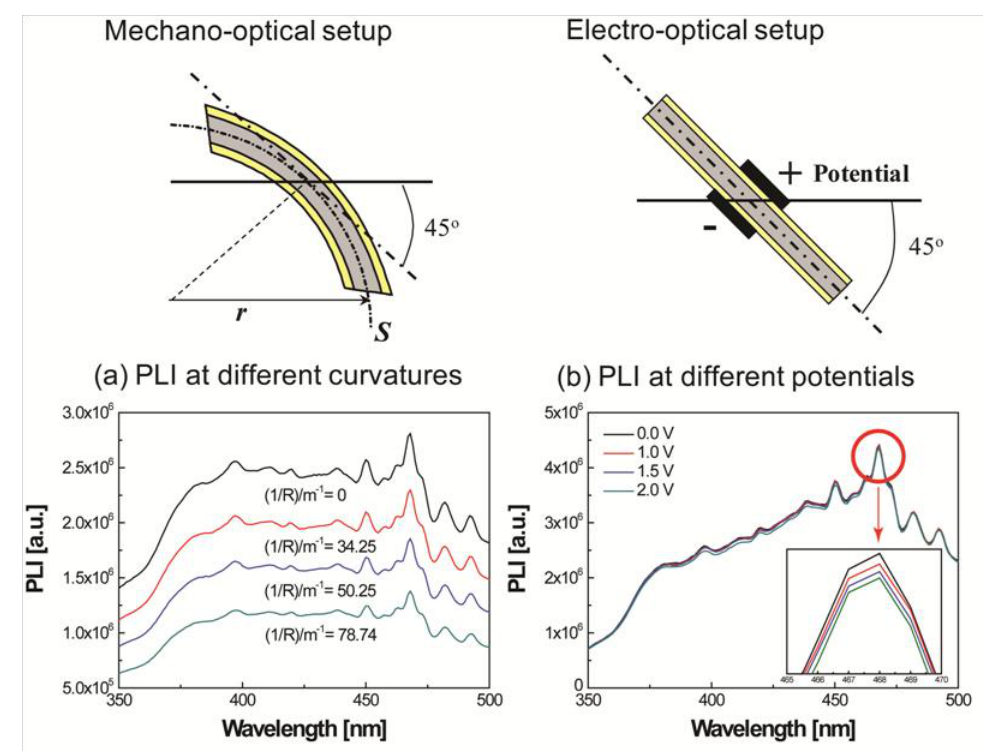
Figure 6. Mechano-optical property set-up and (a) PL intensity at different curvatures and, electro-optical property set-up and (b) PL intensity at different applied